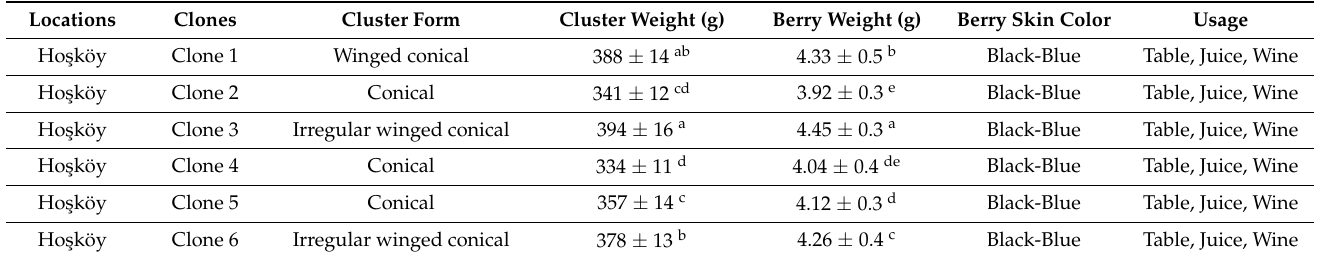
Table 1. Some morphological traits of the six ‘Köhnü’